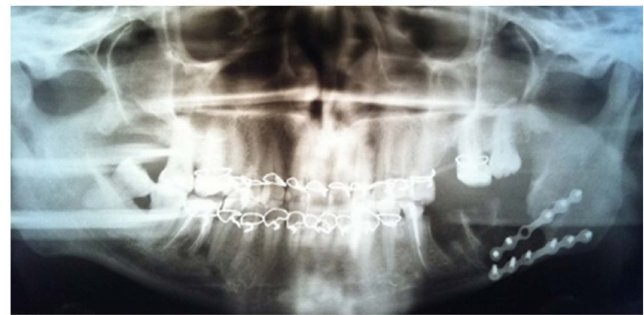
Figure 4. Patient orthopantomogram 1 day after surgery.